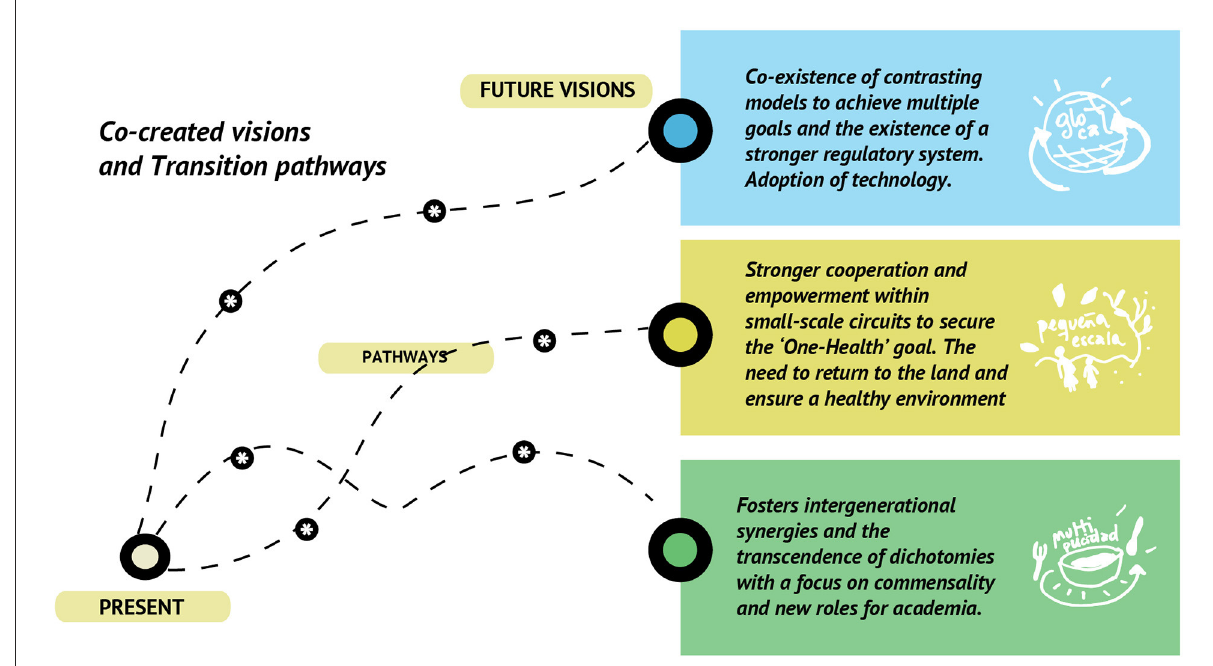
FIGURE2 Visions and transition pathways: synthesis of the three co-created visions and action-pathways developed in the last virtual event held in October